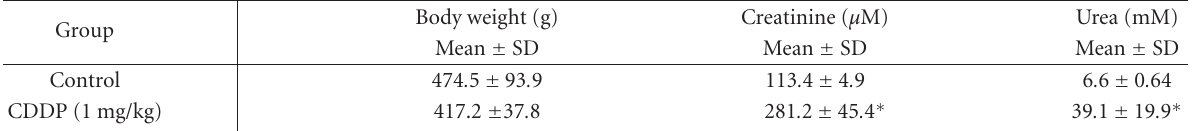
Table 1. Nephrotoxicity after chronic treatment with CDDP. Rats were injected IP with CDDP (1mg/kg) twice weekly for 10 weeks and sacrificed one week after the last dose. Values are means ± SD. N = 8 . ∗ denotes that P < . 05. Group